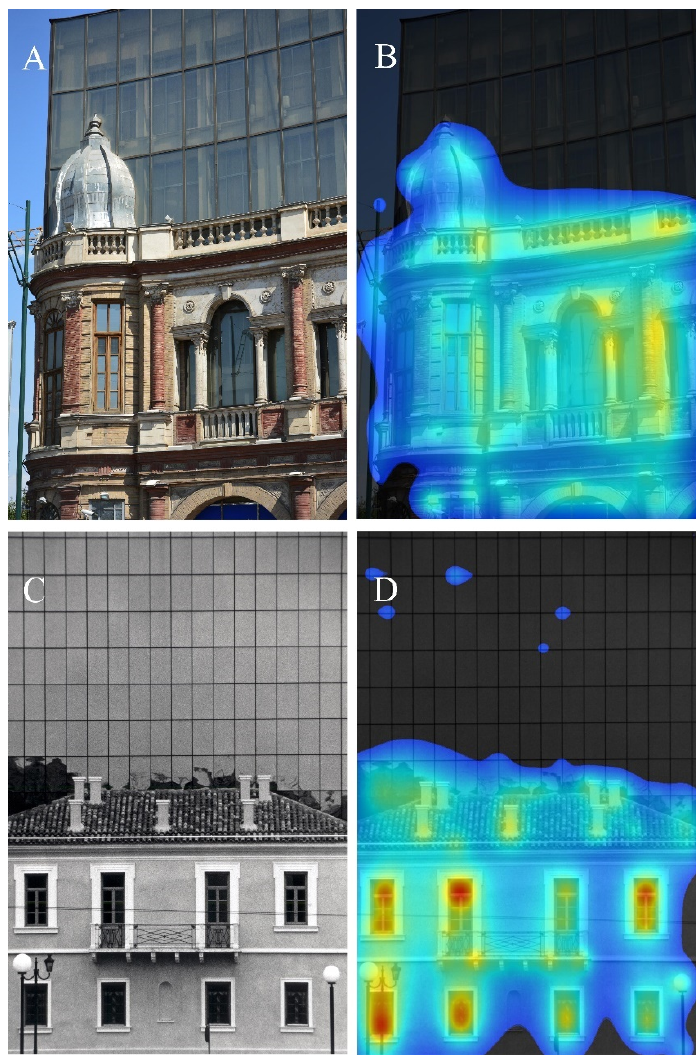
Figure 3. A 1920s building with a glass façade building directly behind it, in Hasanabad square, Tehran, Iran in a color image ( A , B ); and an 1830s building with a glass façade directly behind it in Panepistimiou Street in Athens, Greece in a black and white image ( C , D ).